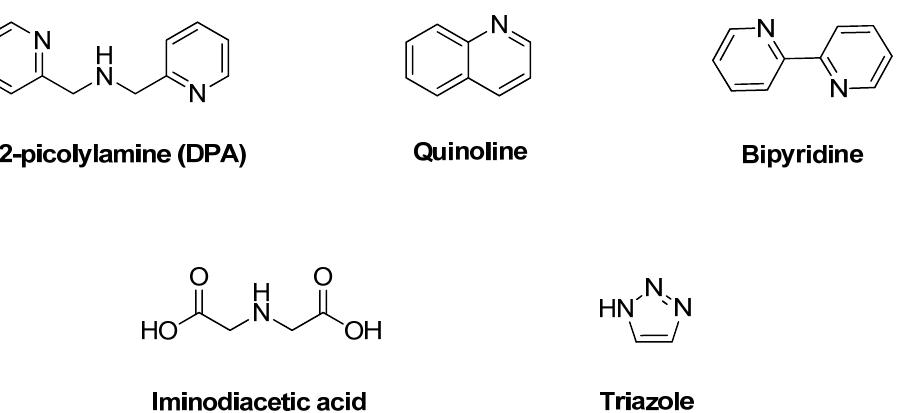
Figure 1. The frequent main structure of fluorophore probe used for binding site or receptors in fluorescence chemosensor. (as di-2-picolylamine (DPA, quinoline, bipyridine, iminodiacetic acid, and